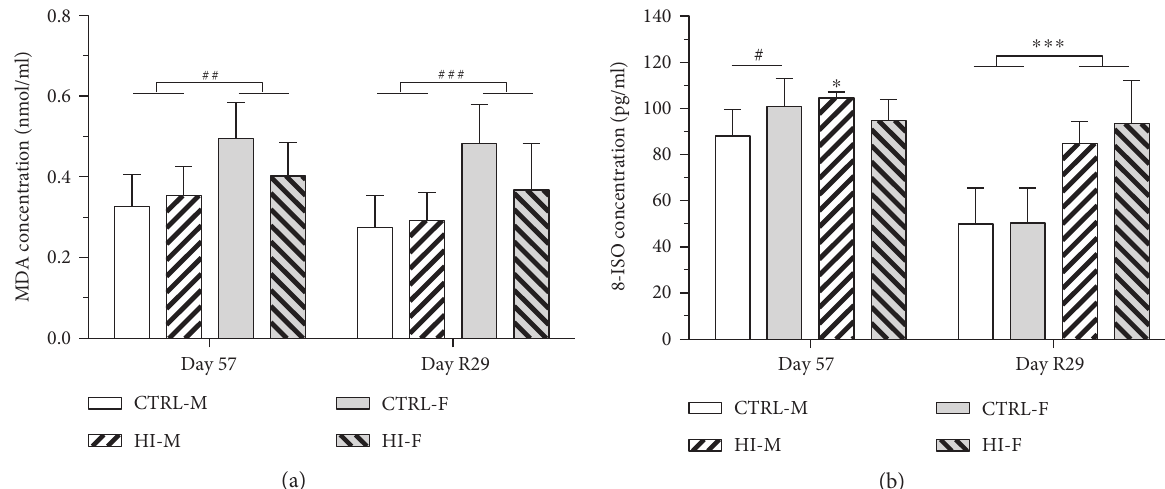
Figure 5: Plasma levels of lipoperoxidation products, mean +SD. (a) MDA, day 56: n = 4 − 10 and day R29: n = 5 − 10 . (b) 8-ISO, day 56: n = 4 − 10 and day R29: n = 5 − 10 . ∗ p < 0 05 and ∗∗∗ p < 0 001 for e ff ect of HI-dosing. # p < 0 05 , ## p < 0 01 , and ### p < 0 001 for e ff ect of sex.